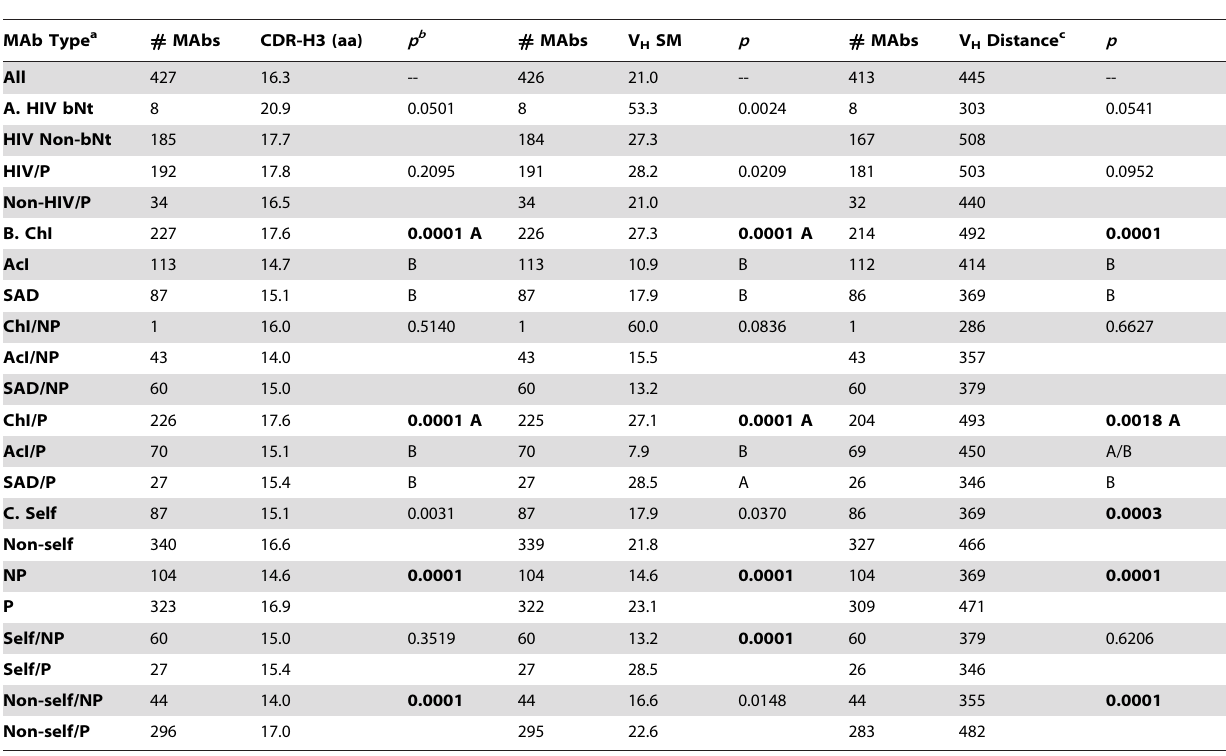
Table 1. Comparison of CDR-H3 length, SM and distance from D H of V H genes among MAbs of known Ag specificity associated with HIV infection (Table 1A), chronic infection (ChI), acute infection (AcI) or systemic autoimmune disease (SAD) (Table 1B), and self vs. non-self (Table